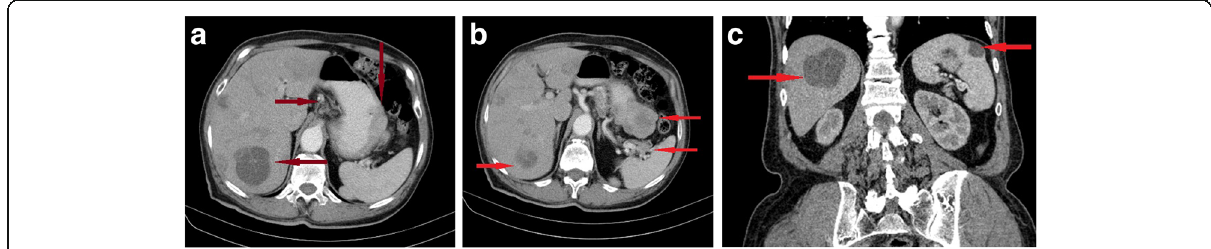
Fig. 2 A 50-year-old male presented with vomiting of blood and dyspepsia for 3 weeks; a , b contrast-enhanced CT (arterial phase with oral contrast) axial scans show diffuse thickness of the greater curvature with an exophytic mass showing heterogeneous enhancement with central breakdown, the mass measures about (3.5 × 2.0 cm), other findings are perigastric, splenic hilar lymph nodes and multiple hepatic focal lesion. c Contrast-enhanced CT abdomen coronal scans show splenic and hepatic focal lesions. Final diagnosis: stage T4N1M2 gastric